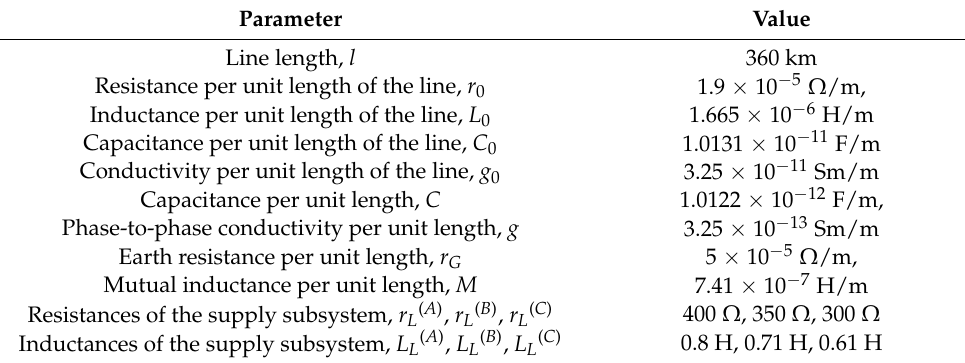
Table 1. The parameters of the long line and the equivalent load.